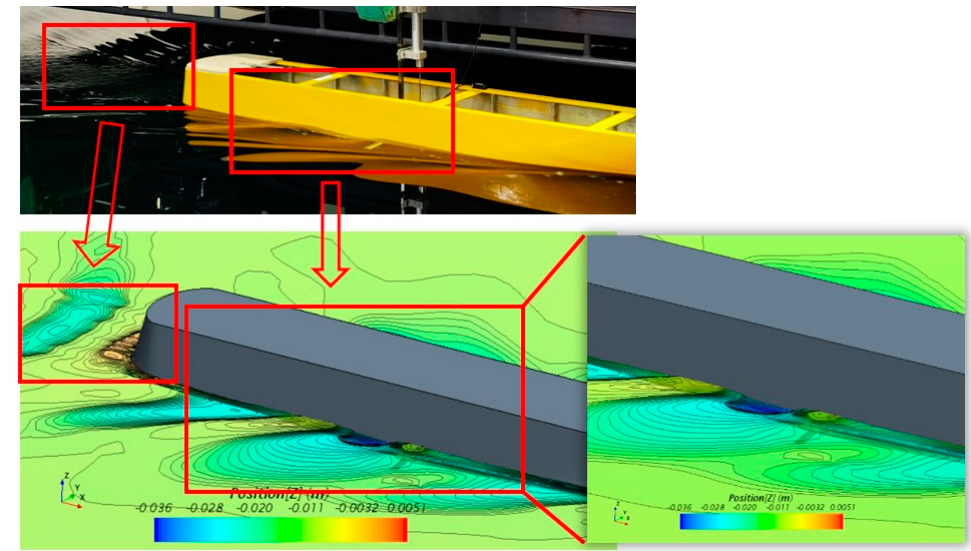
Figure 14. Wave form contour with 20° fins at 18 kn.